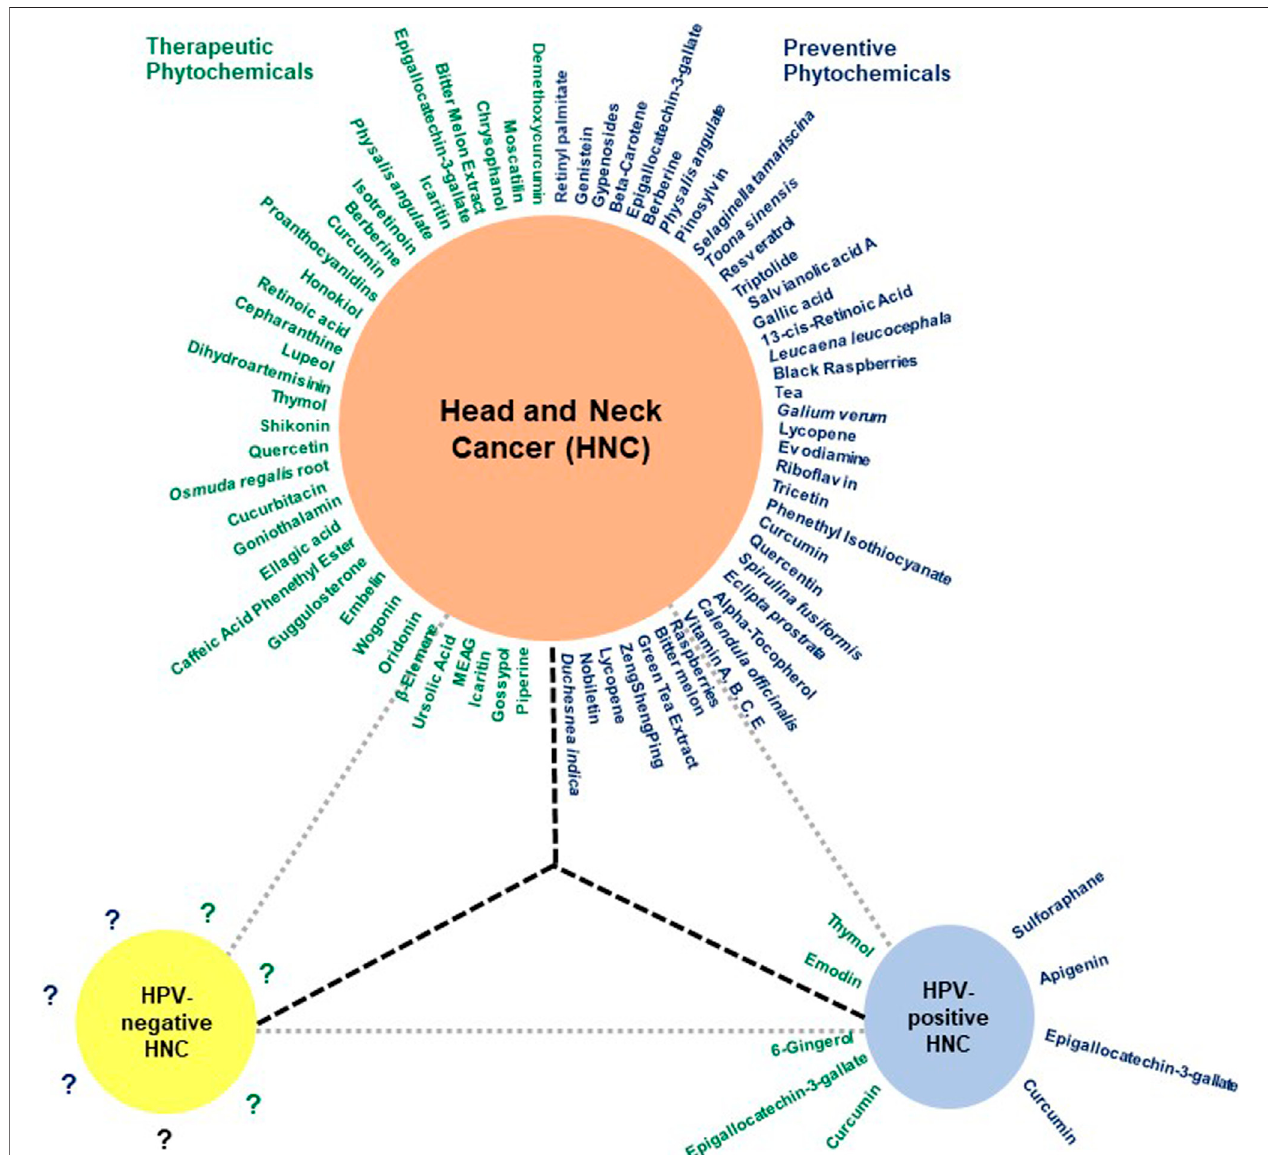
FIGURE 3 | The huddle of chemopreventive and chemotherapeutic phytochemicals in HNC. Schematic diagram showing phytochemicals with chemopreventive and chemotherapeutic properties in blue and green, respectively. Since most reports addressing the effect of herbal derivatives on HNC lacked HPV-related information, the data may not be directly applicable to HPV-negative HNC and require prior validation in HPV-negative HNC cells. Additionally, the HPV-positive HNC remains a poorly explored area.